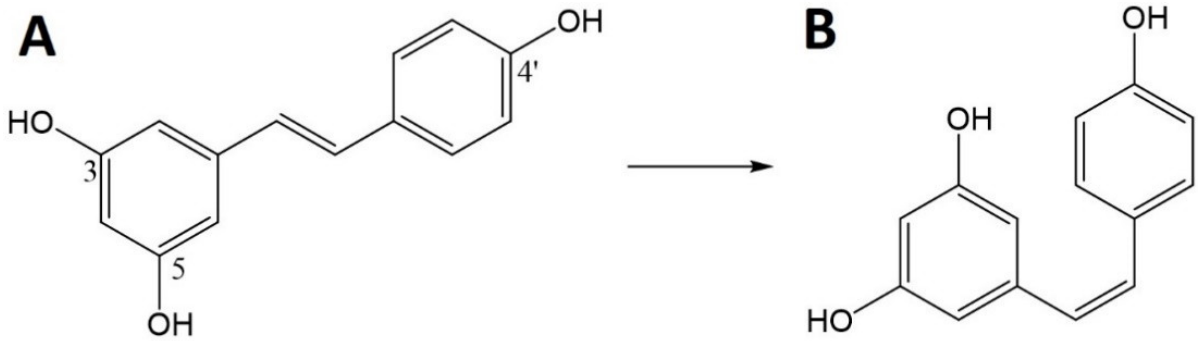
Figure 6. Chemical structure of resveratrol (Res)— trans ( A ) and cis ( B ).